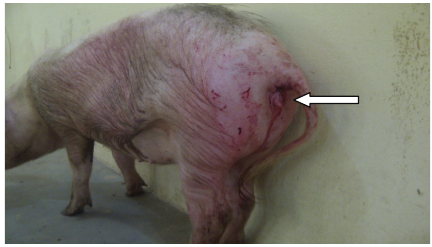
Figure 2: The pig after surgery. Arrow pointing at the